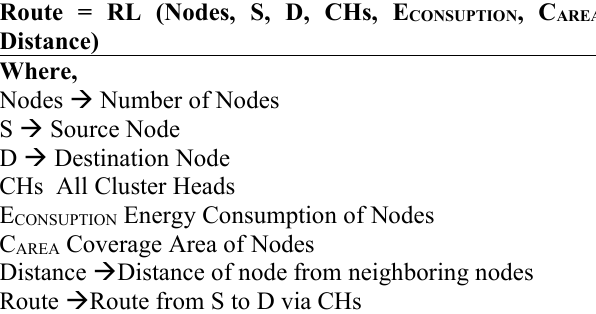
Algorithm: CH Selection using RL approach